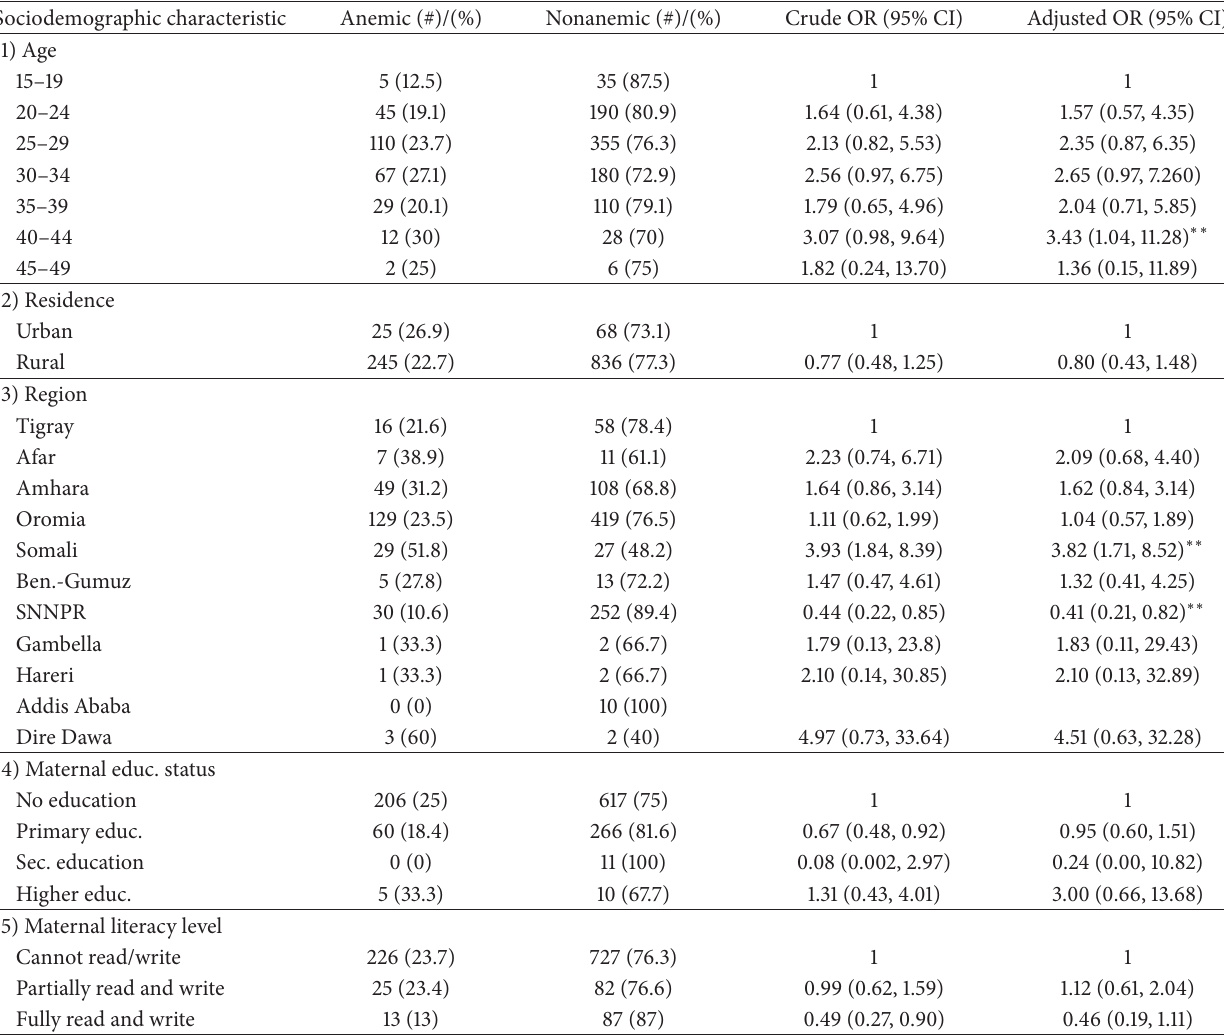
Table 1: Sociodemographic characteristics of pregnant mothers and their association with anemia during pregnancy in Ethiopia, EDHS 2011. Sociodemographic